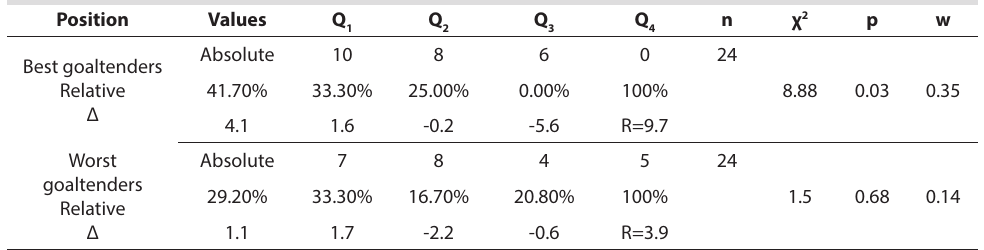
TABLE 6. Comparison of the Best and Worst Goaltenders